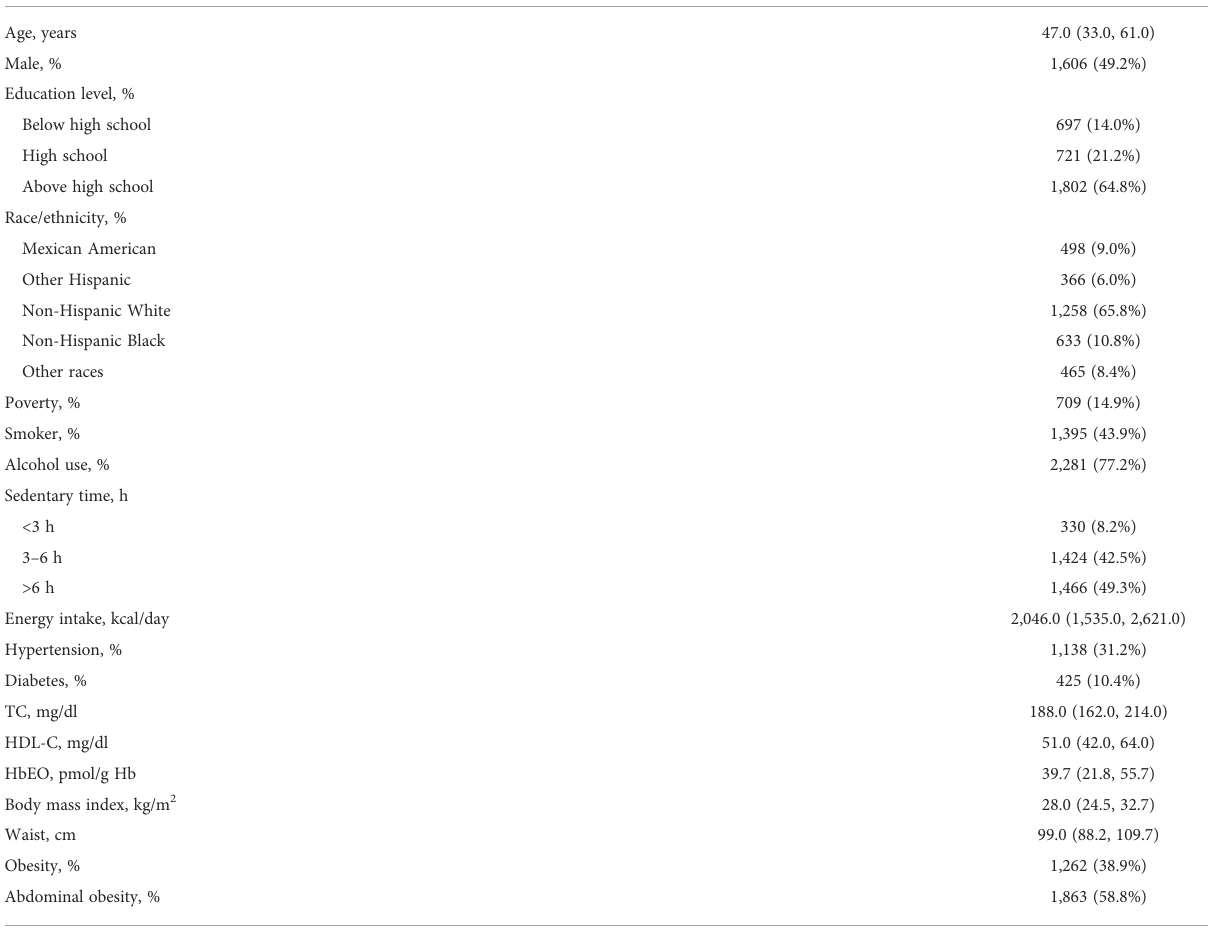
TABLE 1 Survey-weighted, sociodemographic, and health status characteristics of adult NHANES 2013 – 2016 participants with available blood ethylene oxide ( n = 2,721).